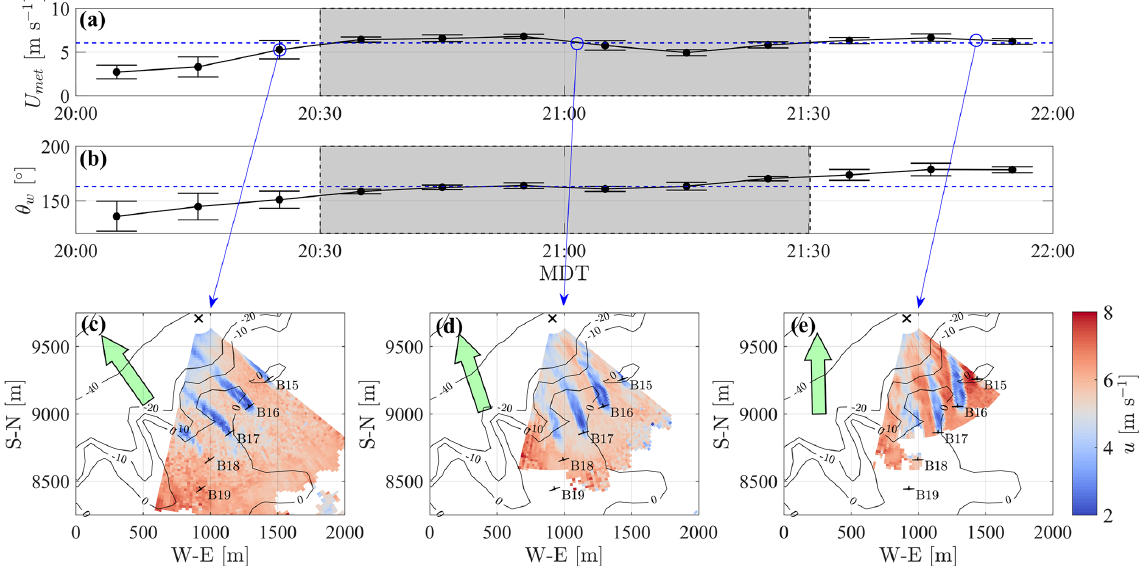
Figure 7. 3D lidar scans of five wind turbines. (a) The 10min average wind speed measured from the anemometers installed at 50 and 80m height on met tower no. 1. The error bar represents the standard deviation over 10min. The shaded area represents the interval selected for the LiSBOA application. (b) The 10min average wind direction in the geophysical reference system measured from the vanes installed at 50 and 80m on met tower no. 1. (c–e) Equivalent velocity fields measured with PPI scans at different times. The green arrow is oriented as being the mean wind direction measured by met tower no. 1, while the black cross indicates the lidar